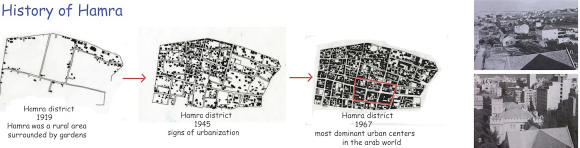
Figure 2. Evolution of the urban fabric in Hamra, (Khalaf, Kongstad, 1973) Figure 3. Reflecting the “Spirit of a Place and model